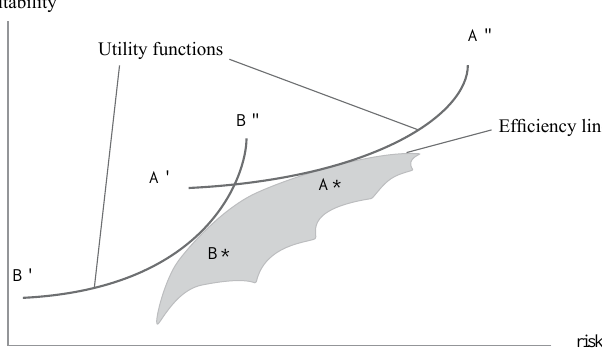
Fig. 1. Efficiency line and utility functions of modern portfolio